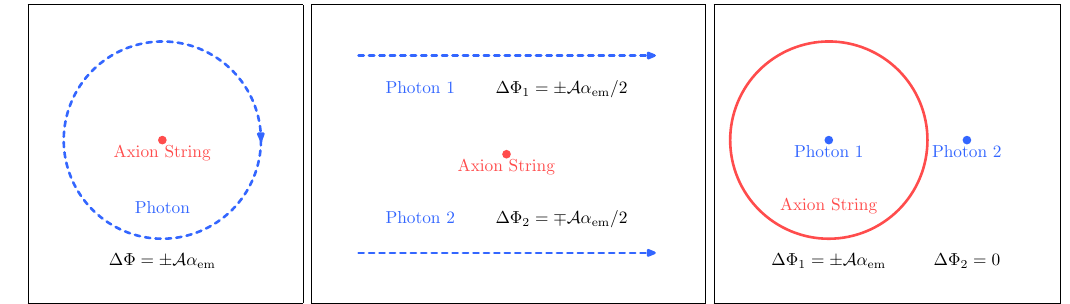
Figure 1 . The observable e(cid:11)ects of cosmic axion strings (red dots and red lines) on the polarization of photons passing by (blue dots or blue dashed lines) in various situations. The red and blue curves represent a string or a photon that lies on the surface while the red and blue dots represent a string or a photon that goes through the surface. (Left) Photons that go around an axion string accumulate a polarization rotation angle (cid:1)(cid:8) = (cid:6)A (cid:11) em . (Middle) Photons that go past an axion string from and to in(cid:12)nitely far away on the opposite side of a string accumulate a relative phase of polarization rotation (cid:1)(cid:8) = (cid:6)A (cid:11) em . (Right) Photons that pass through an axion string loop from and to in(cid:12)nitely far away get a polarization rotation angle of (cid:1)(cid:8) = (cid:6)A (cid:11) em while photons that do not get 0 polarization rotation